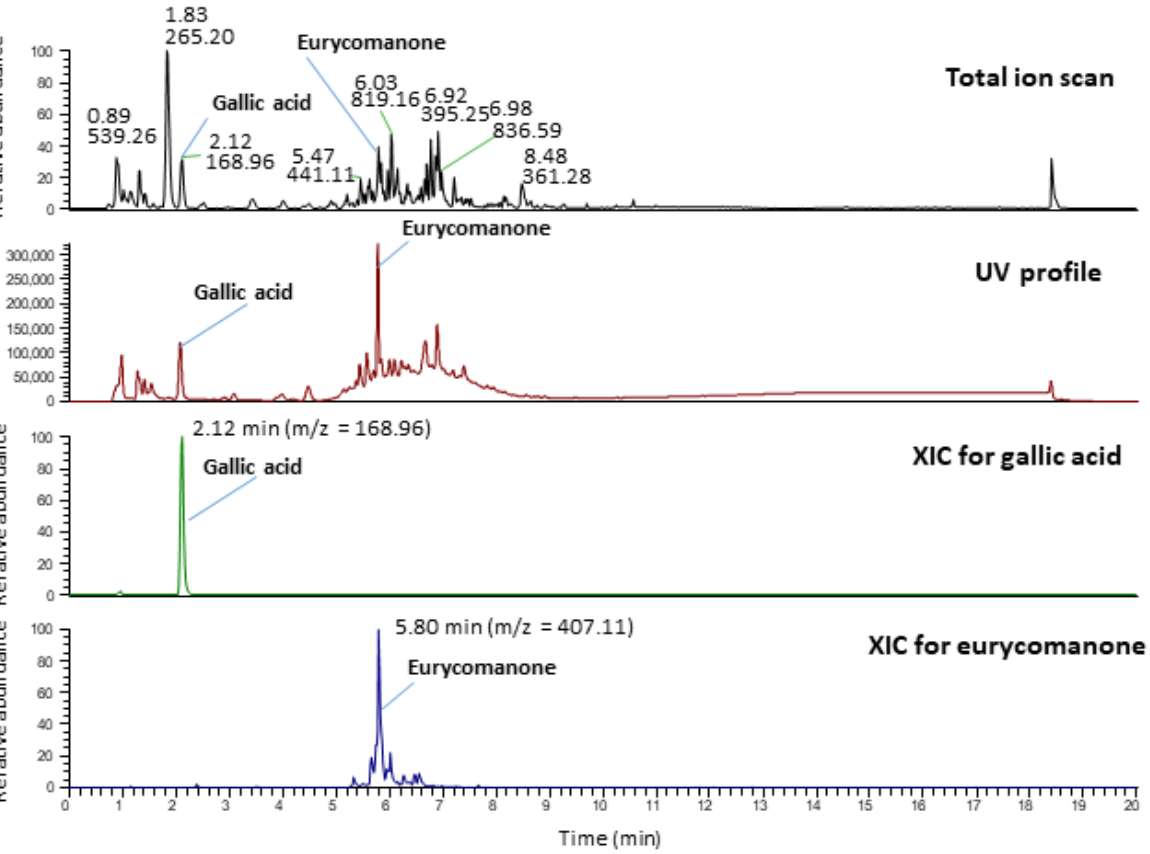
Figure 2. The LC-MS profile of the P.SLP formulation and the extracted ion mass of chemical markers gallic acid (retention time (t R ) = 2.1 min, mass-to-charge ratio ( m / z ) = 169) and eurycomanone (t R = 5.80 min, m / z =